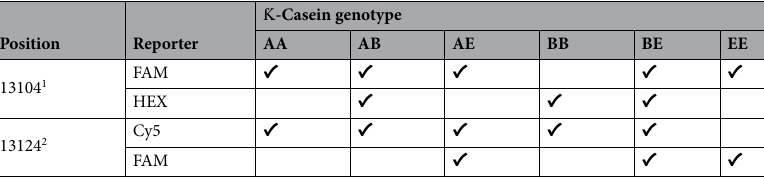
✔ FAM ✔ ✔ Table 3. Schematic representation of the expected results of duplex qPCR assays with each reporter dye in the 13104 and 13124 positions. 1 The 13104_C probe for B detection was labelled with HEX reporter dye and the 13104_A probe for A and E detection was labelled with FAM reporter dye. 2 The 13124_G probe for E detection was labelled with FAM reporter dye and the 13124_A probe for A and B detection was labelled with Cy5 reporter dye.